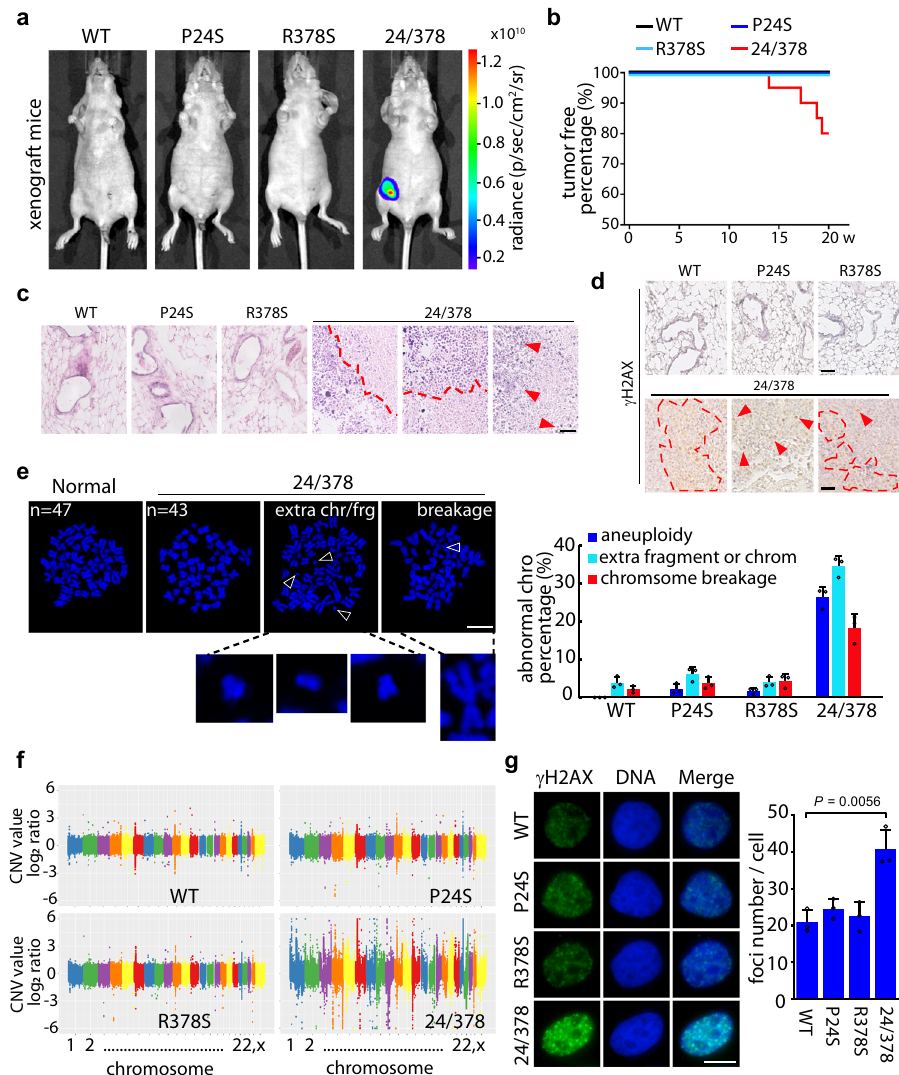
Fig. 6 P24S/R378S double mutation promotes tumorigenesis in mice. a In vivo imaging of mice bearing xenografts of MCF10A cells harboring different BARD1 variants. Luciferase-MCF10A cells expressing WT or different BARD1 variants combined with p53 knockout were transplanted into the